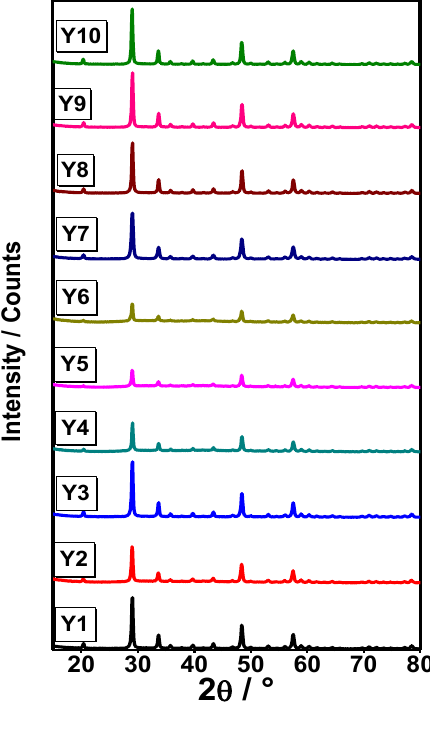
Figure 2. X-ray diffraction (XRD) patterns of Y 2 O 3 systems heat-treated from 700 °C to 900